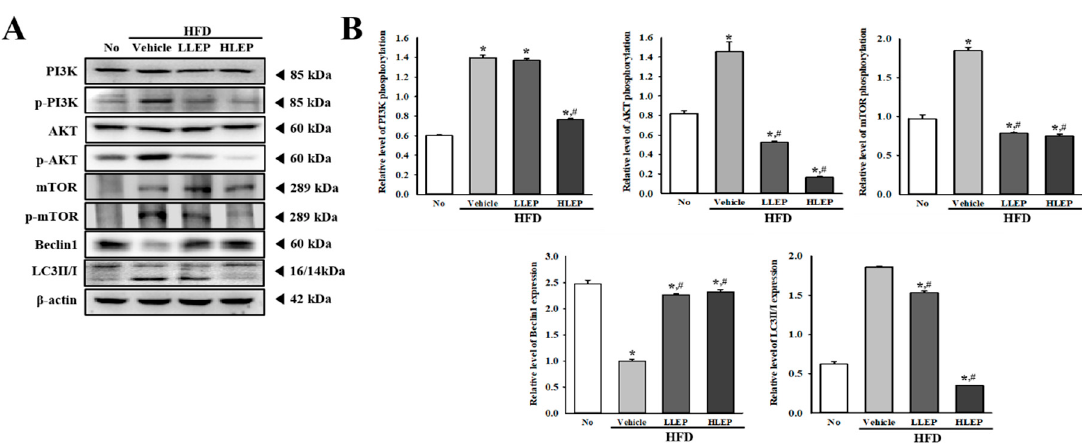
Figure 6. Expressions of key marker proteins for PI3K/AKT/mTOR pathway and autophagy in liver tissue. ( A ) Western blot image of marker proteins. The expression levels of PI3K, p-PI3K, AKT, p-AKT, mTOR, p-mTOR, Beclin1, and LC3II / I in total liver proteins were detected with specific antibodies. The level of β -actin is shown as the endogenous control. ( B ) Relative level of phosphorylation and expression of marker proteins. The band intensity of proteins was determined using an imaging densitometer, and the relative level of each protein was calculated based on the intensity of actin protein as an endogenous control. Three to five mice per group were used in the preparation of tissue homogenate, and Western blot analysis was assayed in duplicate for each sample. Data represent the mean ± SD. * p < 0.05 compared to the No-treated group. # p < 0.05 compared to the HFD + Vehicle-treated group. Abbreviations: HFD, high-fat diet; LLEP, low concentration of LEP; HLEP, high concentration of LEP; PI3k, phosphatidylinositol-3-kinase; mTOR, mammalian target of rapamycin.